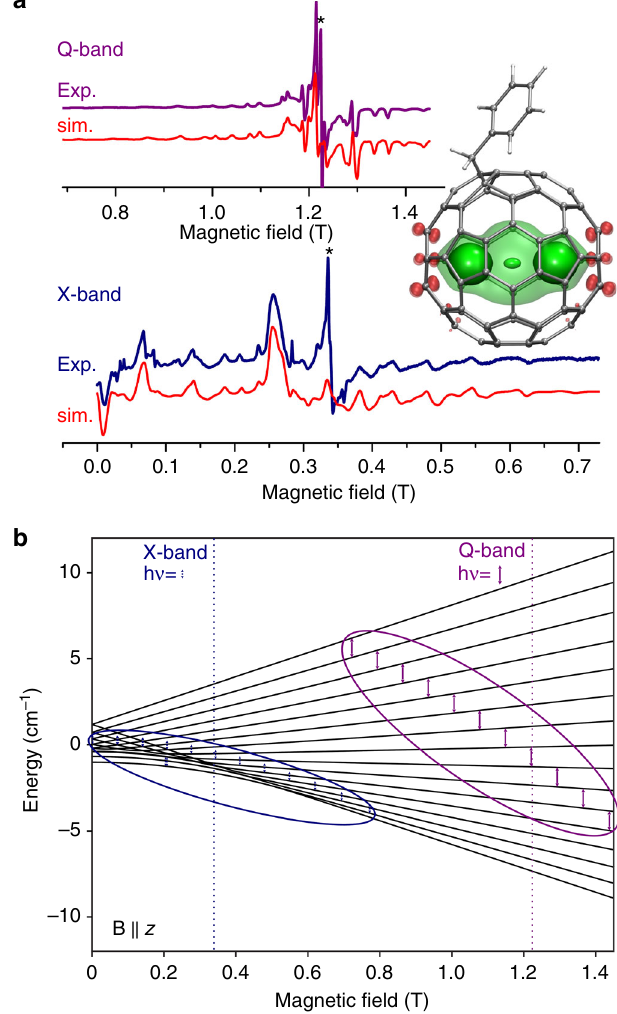
Fig. 3 Electron paramagnetic resonance (EPR) spectroscopy of {Gd 2 }. a X-band and Q-band EPR spectra of frozen {Gd 2 } solution in toluene near 100 K together with the spectra simulated for spin S = 15/2 with g iso = 1.987 and zero fi eld splitting (ZFS) parameters D = 1.00 GHz and E = 0.22 GHz (inhomogeneous broadening is accounted for by ZFS strain Str D = 0.029 GHz and Str E = 0.027 GHz); asterisks mark unidenti fi ed signals (presumably of low spin states or organic impurities), the inset shows the spin-density distribution in {Gd 2 }; b Zeeman splitting for spin S = 15/2 with the above ZFS parameters (magnetic fi eld is parallel to z-axis of the ZFS tensor); also shown are energies of the X-band (9.4 GHz) and Q-band (34 GHz) microwave photons, EPR-active transitions (ovals and small arrows), and the resonance fi elds corresponding to the g-factor of 1.987 (vertical dotted